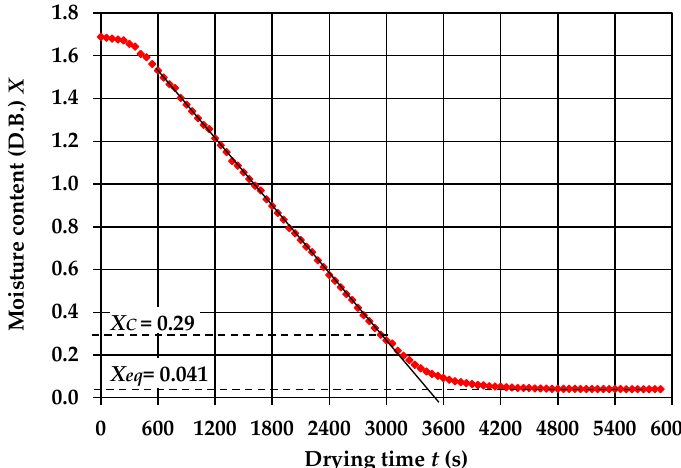
Figure 3. Experimental drying curve of alfalfa. From it, the critical moisture content X C and the equilibrium moisture content X eq can be obtained.